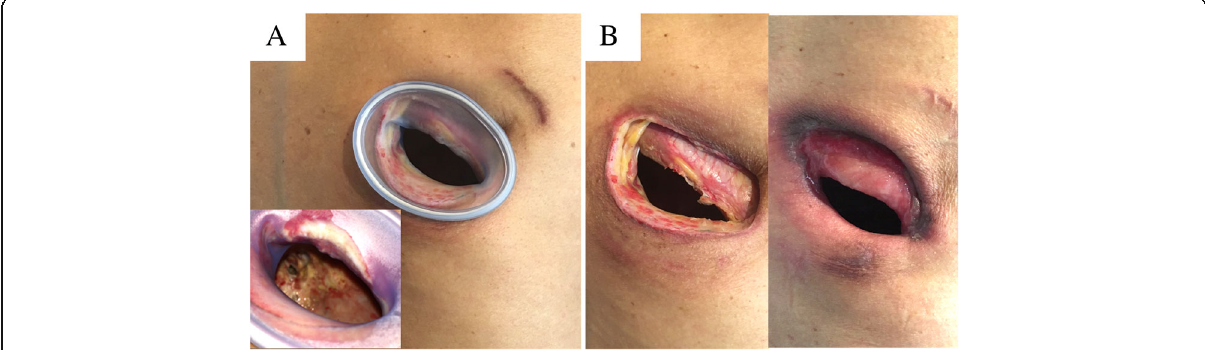
Fig. 2 The image shows the fenestration procedure with the insertion of the Lap-protector, and the presence of the fistula is confirmed through the fenestration wound ( a ). The image shows the changes in the skin and subcutaneous tissue after fenestration surgery ( b ). Image obtained 1-month post-procedure (Left). Image obtained 6 months post-procedure